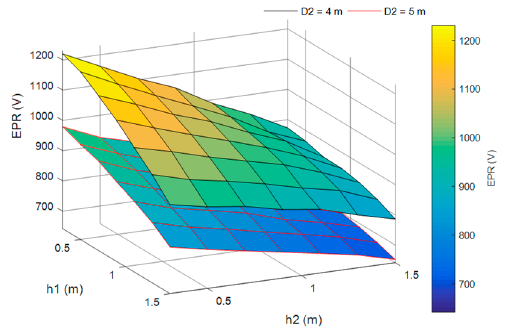
Figure 4. EPR, 500 Ωm/ 100 Ωm/ 2 m, D 1 = 2 m, D 2 = 4 and 5 m.